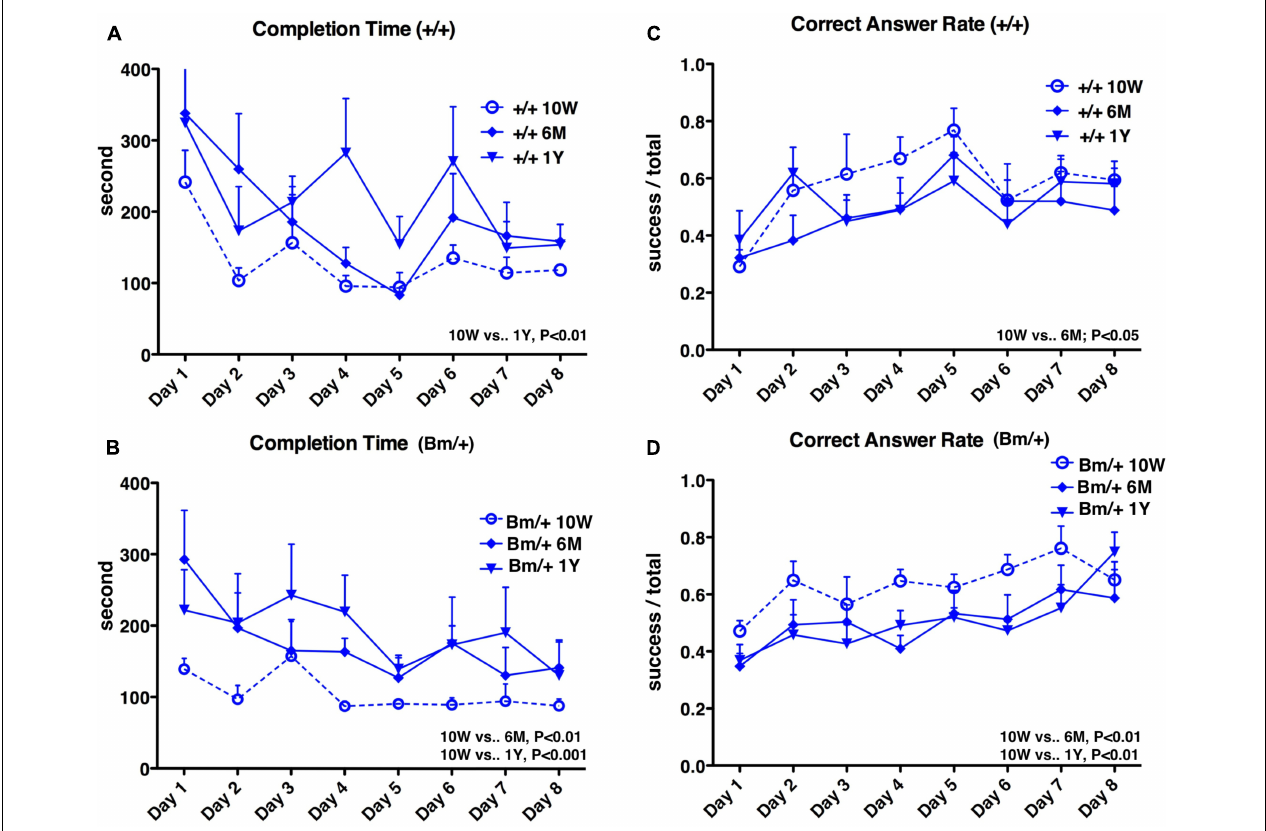
FIGURE 1 | Spatial working memory is impaired with age. Eight-arm radial maze test was performed on wild-type mice ( A , C ,+/+; n = 6) and mutant-BiP mice ( B , D , Bm/+; n = 8) at 10 weeks (10W), 6 months (6M), and 1 year (1Y) after birth. Tests were carried out for 8 days at each time point. Completion times (A,B) are shown as the mean time (seconds) of each group + SEM. Differences were determined by one-way repeated measures ANOVA followed by Bonferroni’s multiple comparison testing. (A) +/+; ANOVA, P = 0.0050; 10 weeks vs. 1 year, P < 0.01. (B) Bm/+; ANOVA, P = 0.0001; 10 weeks vs. 6 months, P < 0.01; 10 weeks vs. 1 year, P < 0.001. Correct answer rates (C,D) are shown as the mean of each group + SEM. The ratio of successful attempts to overall attempts was the correct answer rate (0.0–1.0). Differences were determined by one-way repeated measures ANOVA followed by Bonferroni’s multiple comparison testing. (C) +/+; ANOVA, P = 0.0412. 10 weeks vs. 6 months; P < 0.05. (D) Bm/+; ANOVA, P = 0.0006; 10 weeks vs. 6 months, P < 0.01; 10 weeks vs. 1 year, P <